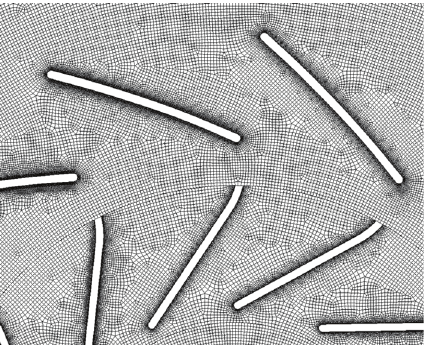
Figure 2: A view of the meshed portion between the impeller and di ff user of the centrifugal fan.